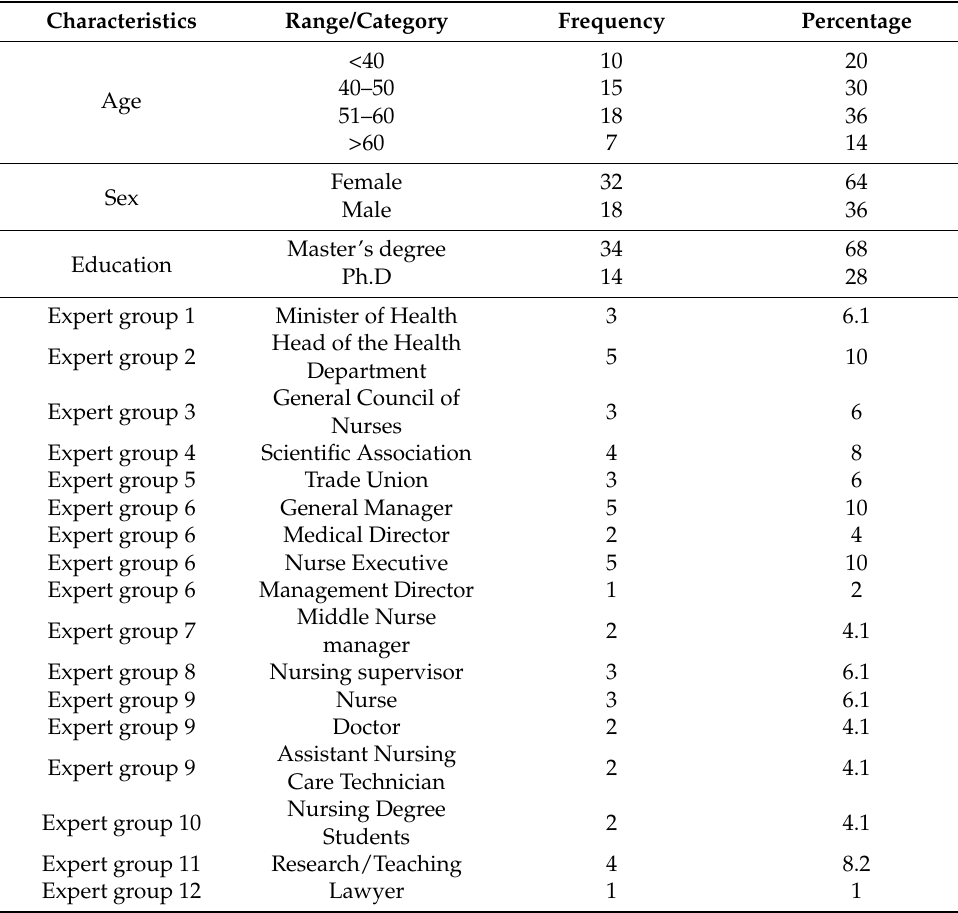
Table 1. Sociodemographic characteristics of the panel